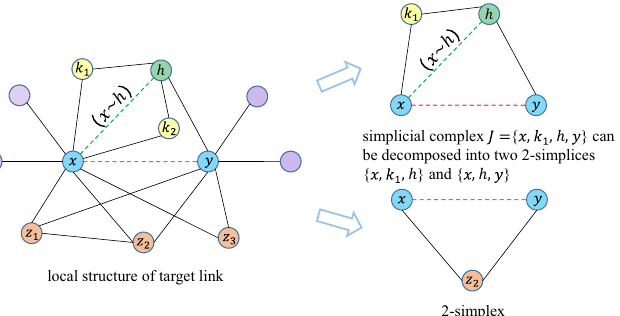
Figure 4. Schematic diagram of the topology around the target link. In this figure, the node pair x and y is to be predicted, { z 1 , z 2 , z 3 } are their common neighbors, and they form 2-simplices { x , z i , y } , i = 1, 2, 3 . h is the hidden neighbor of endpoint x , and ( x ∼ h ) is the latent edge. The simplicial complex J can be decomposed into two 2-simplices { x , k 1 , h } and { x , h , y } . Symmetrically, k 1 and k 2 are hidden neighbors of node y